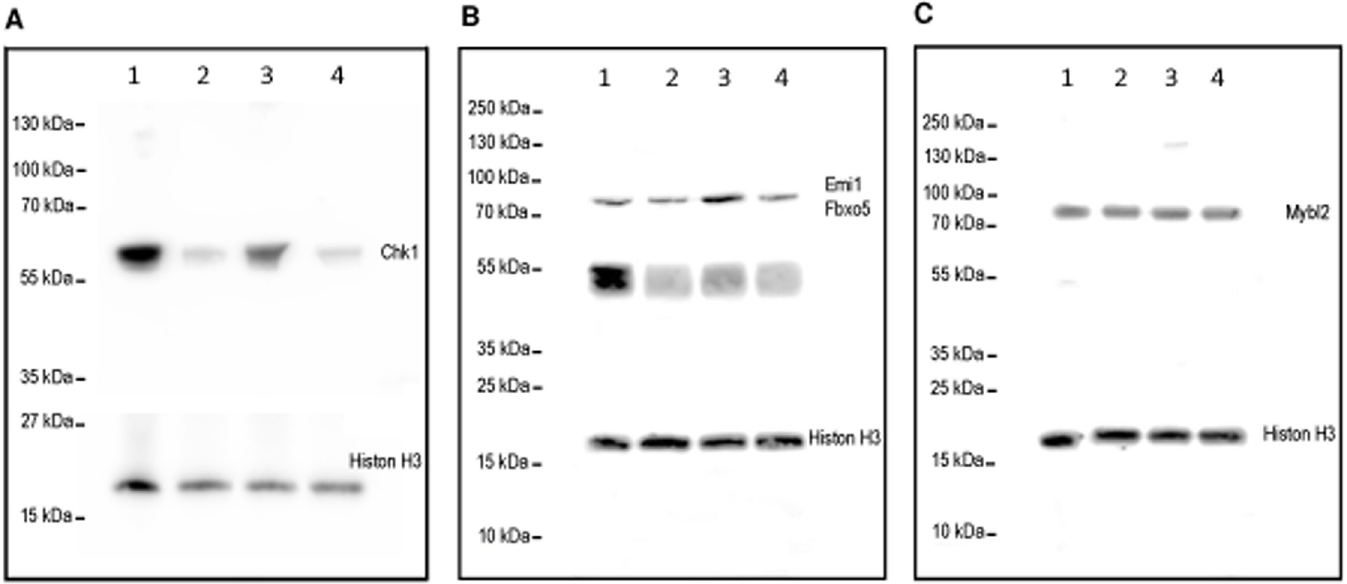
Fig 4. Western Blot analysis of differentially expressed genes. (A) Chk1, (B) Emi1/Fbxo5, (C) Mybl2 protein were detected by western blot analysis. Histone H3 served as the normalization control. Murine mouse muscle cells were cultured for 48 h in growth medium (lane 1), differentiation medium (lane 2), or differentiation medium supplemented with TNF- α (lane 3) or IGF1 (lane 4), respectively. (B) The specificity of the double band between 40 and 50 kDa was confirmed by peptide competition of the Emi/Fbxo5 antibody epitope (S4